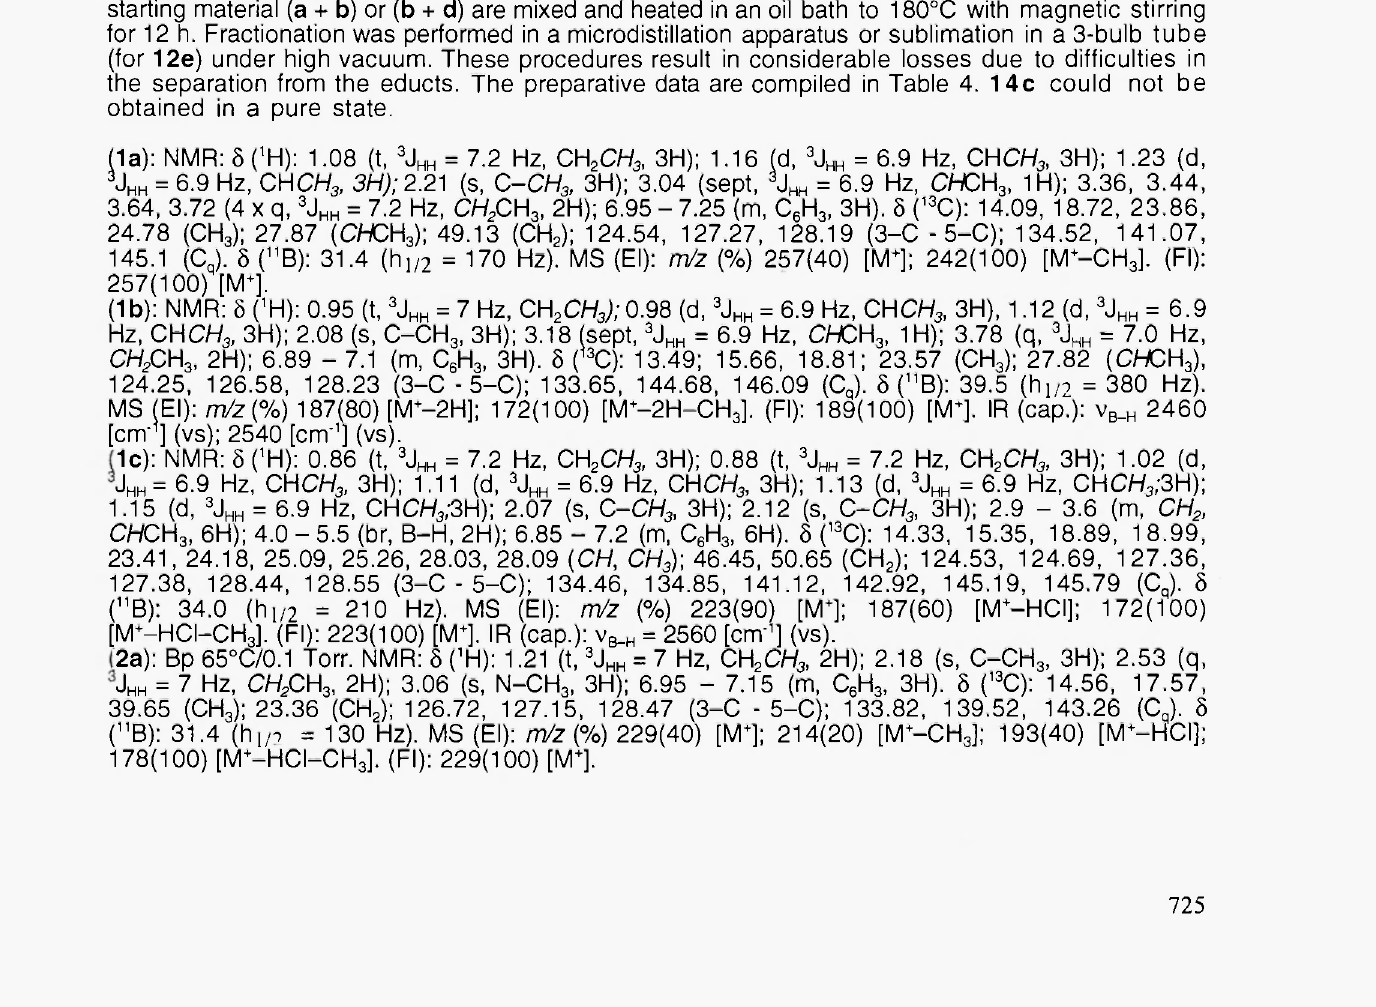
procedures: Compounds of the type c or e respectively are made from equimolar mixtures of a and b or b and d (with the same figures) respectively: 0.05 mol of each starting material (a + b) or (b + d) are mixed and heated in an oil bath to 180°C with magnetic stirring for 12 h. Fractionation was performed in a microdistillation apparatus or sublimation in a 3-bulb tube (for 12e) under high vacuum. These procedures result in considerable losses due to difficulties in the separation from the educts. The preparative data are compiled in Table 4. 14c could not be obtained in a pure